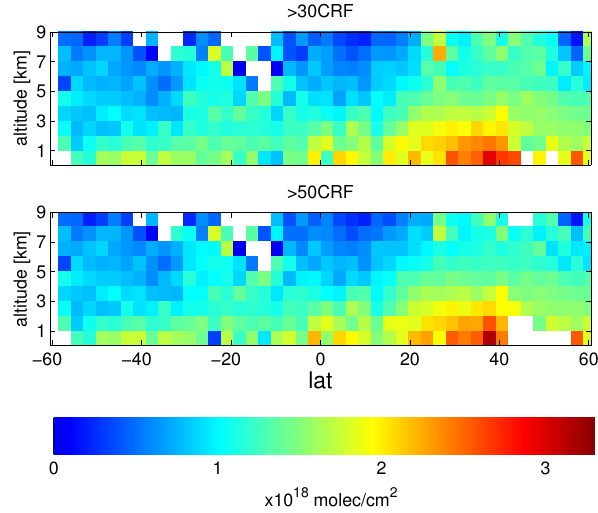
Fig. 4. Example of a meridional cross section of CO PVCDs (av- eraged over 100 ◦ to 120 ◦ E for July–September 2003–2005). The spatial patterns and also the absolute values of the PVCDs for the different thresholds of CRF are almost identical. Using more strict selection criteria, for some locations, no measurements are available for certain cloud altitudes. Note that this latitudinal cross section contains both measurements over land (northern part) and ocean (southern